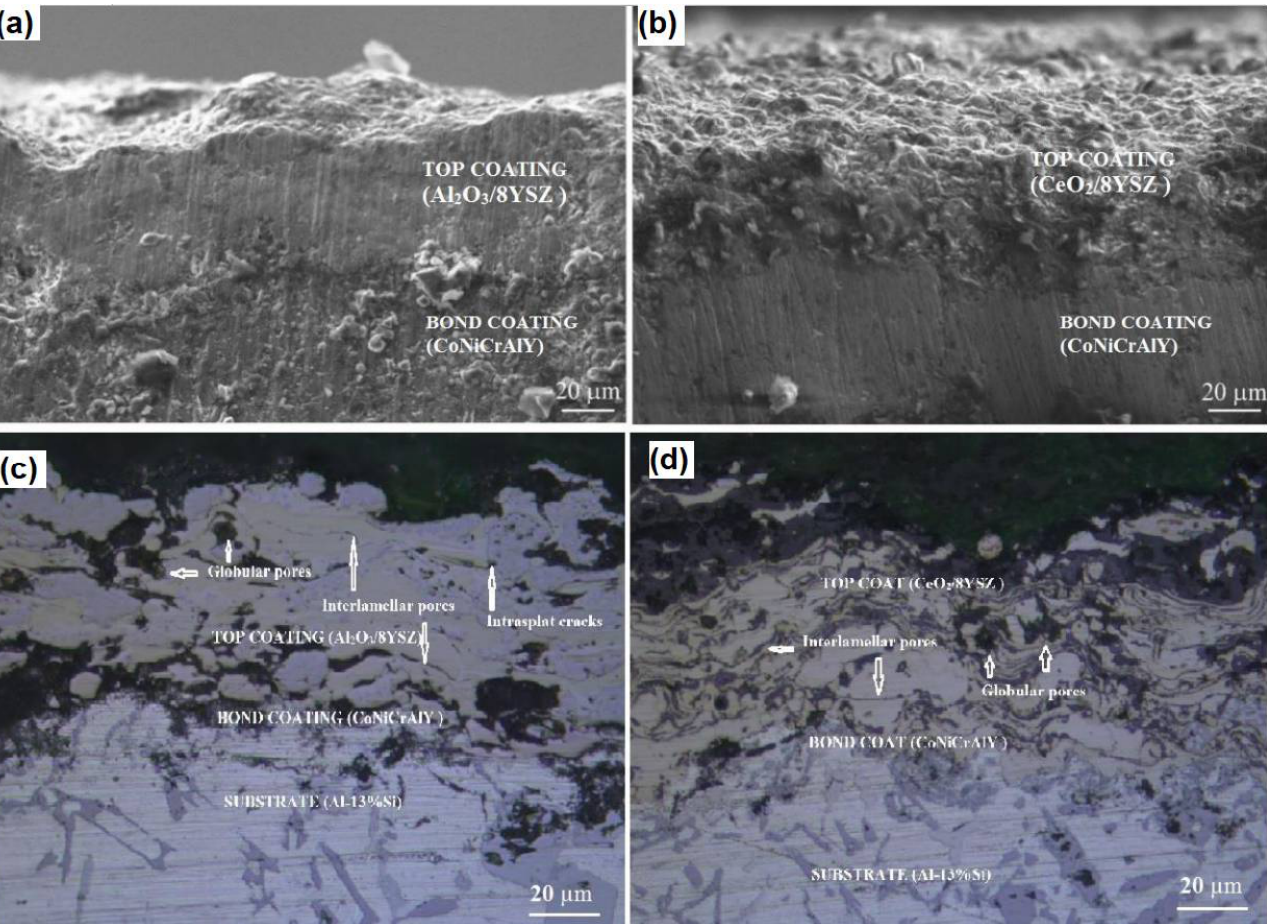
Figure 22. Cross-sectional morphologies of as-sprayed TBCs: ( a ) Al 2 O 3 /8YSZ TBCs and ( b ) CeO 2 /8YSZ TBCs; ( c ) Al 2 O 3 /8YSZ TBCs backscattered election images; ( d ) CeO 2 /8YSZ TBCs backscattered electron images [86].